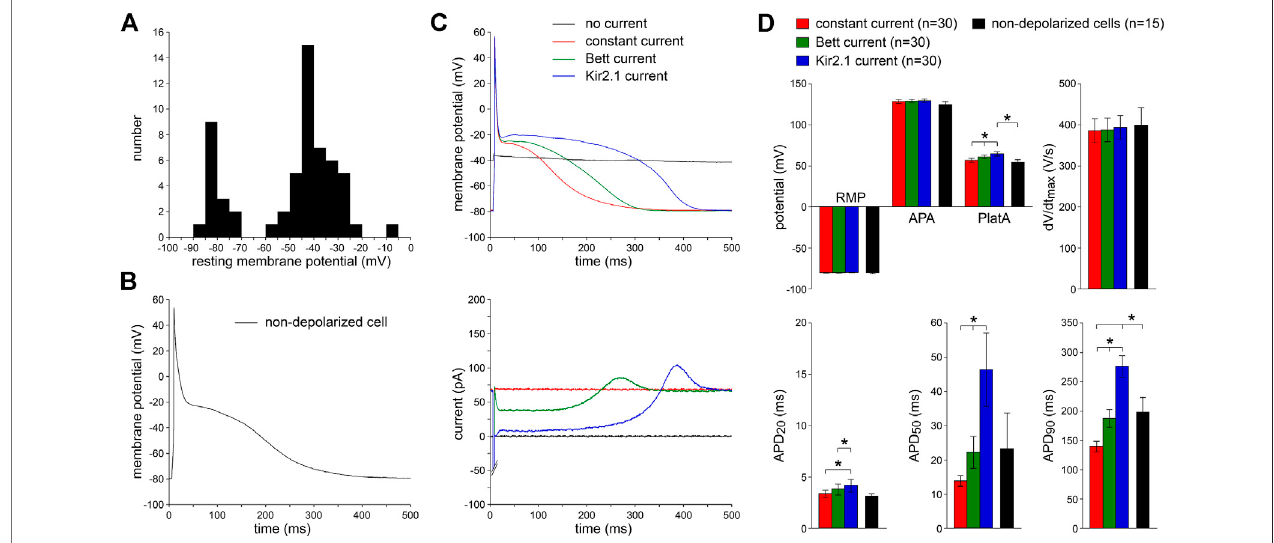
FIGURE 2 | Effects of injection of constant repolarizing current or synthetic I K1 (with moderate or strong recti fi cation, supplied through dynamic clamp) on action potentials of enzymatically isolated human atrial myocytes. (A) Resting membrane potential (RMP) of 58 human atrial myocytes in absence of repolarizing current injection. Note the group of 15 non-depolarized myocytes (leftmost group of bars) with an RMP of − 70 mV or more negative. (B) Typical action potential (AP), elicited at 1 Hz, of a non-depolarized myocyte in absence of any repolarizing current injection. (C) Top: typical APs elicited at 1 Hz in presence of injected constant or I K1 currentwithinoneoriginallydepolarizedcell(withanoriginalRMPnear − 40 mV). Bottom: associatedinjectedcurrents.SyntheticI K1 suppliedasdetailedin Figure1 . (D) Average AP parameters of 30 originally depolarized myocytes during constant current and I K1 injections with dynamic clamp. Non-depolarized cells are the 15 cells of panel A with an RMP of − 70 mV or more negative in absence of any repolarizing current injection. APA, AP amplitude; PlatA, amplitude of the AP plateau; dV/dt max , maximum AP upstroke velocity; APD 20 , APD 50 , and APD 90 , AP duration at 20, 50, and 90% repolarization, respectively. * p <